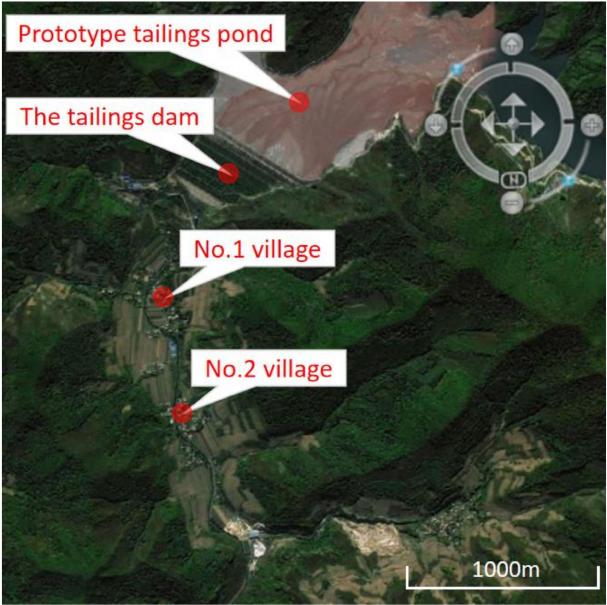
Figure 1. Topographical map of the prototype tailings